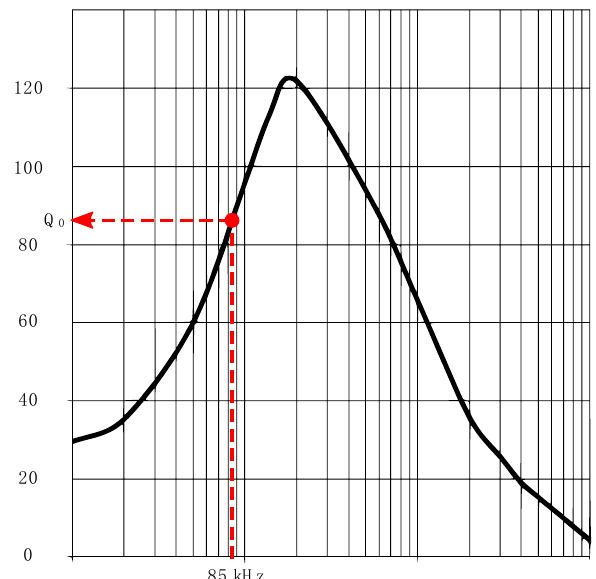
Figure 8. Q-factor of selected coil as a function of frequency of operation (from Würth Elektronik).